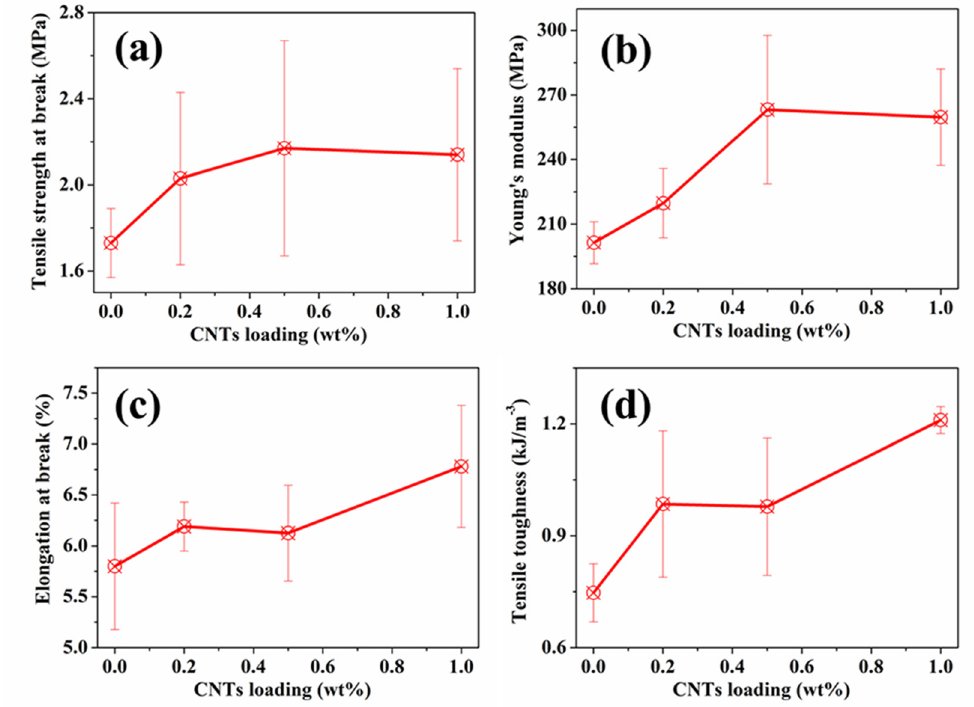
Figure 4. Mechanical properties of alumina/polymer membranes with different CNT loadings: ( a ) Tensile strength at break; ( b ) Young’s modulus; ( c ) Elongation at break and ( d ) Tensile toughness.